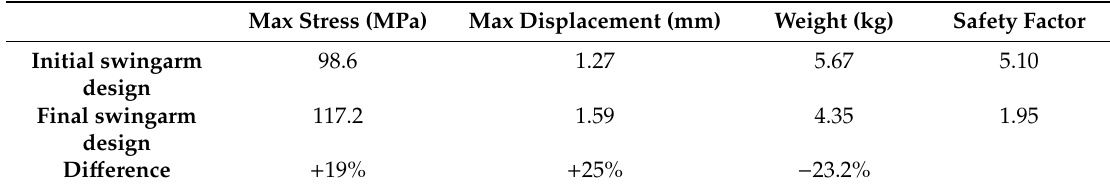
Table 6. Results comparison of the initial and final swingarm